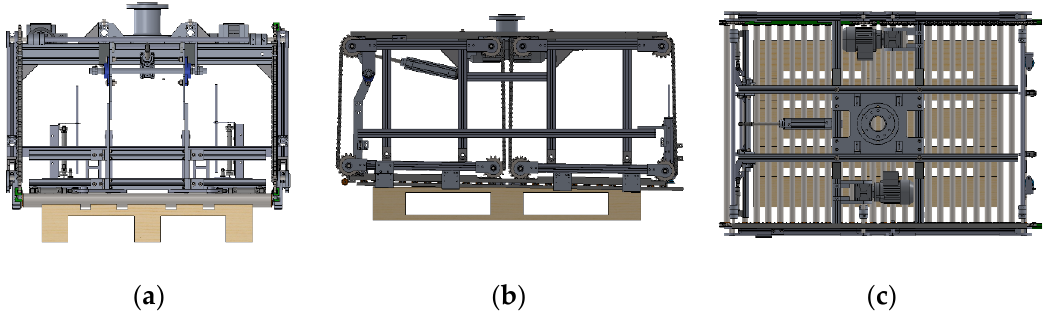
Figure 4 . General views of the roller shutter gripper. ( a ) Front view, ( b ) side view, and ( c ) top view.